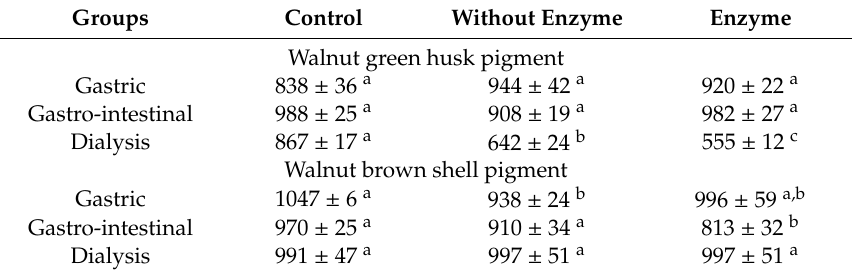
Table 4. The DPPH scavenging activity of walnut green husk and brown shell pigment subjected to simulated in vitro digestion and dialysis ( µ mol TE /